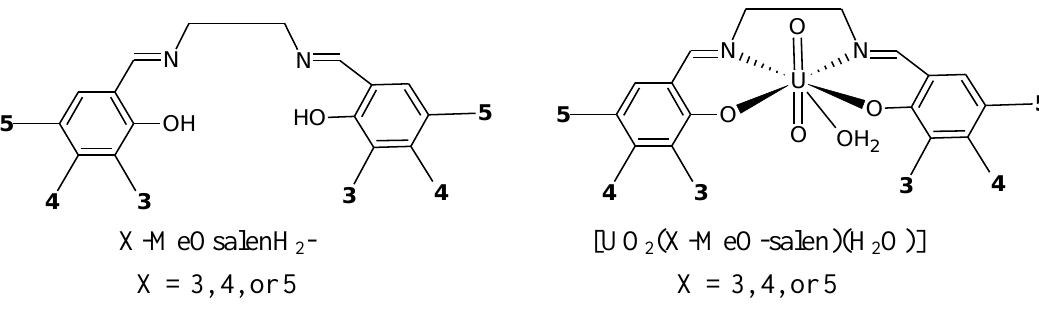
Figure 2. Structural representations of the ligands and complexes used in this study.